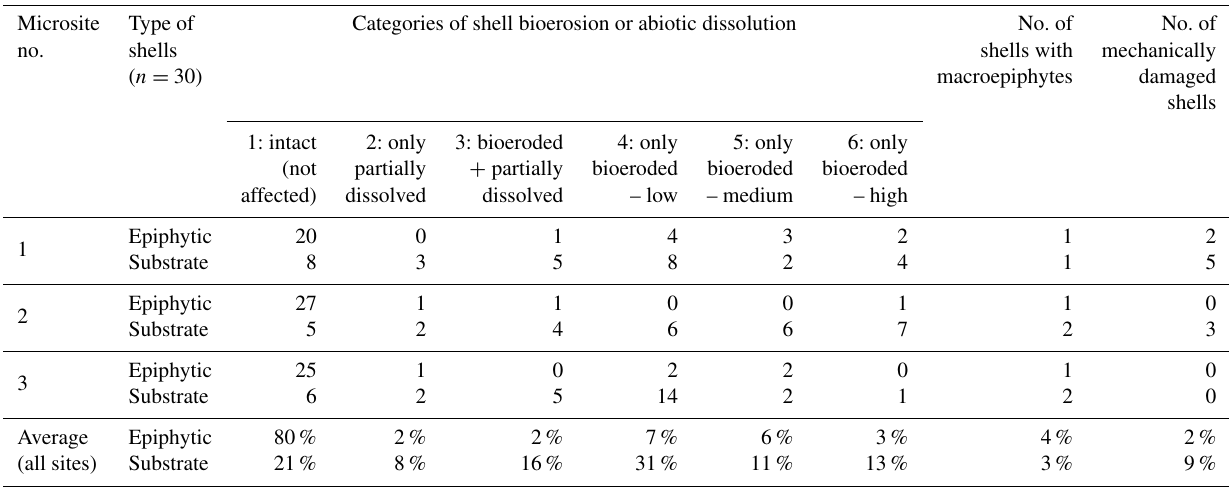
Table 1. Bioerosion, abiotic dissolution, macroepiphytic colonization and mechanical damage of Amphistegina lobifera shells in numbers. Epiphytic and substrate shells of the invasive foraminiferan A. lobifera were collected at three different microsites at a depth of ca. 6m at Balluta Bay, St. Julian’s, Malta; for details on their investigation see Sect. 2. Microsite Type of Categories of shell bioerosion or abiotic dissolution No. of No. of